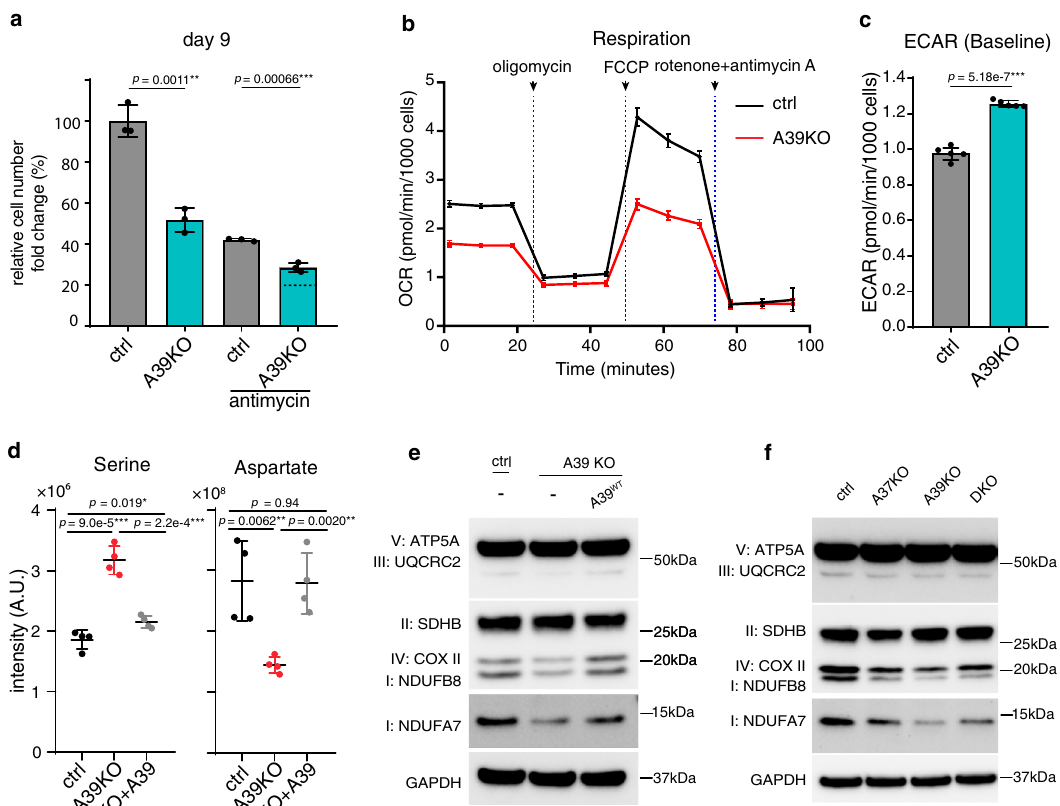
Fig. 6 SLC25A39 converges with SLC25A37-mediated iron homeostasis to support mitochondrial OXPHOS. a Growth fi tness defect in A39 CRISPR KO cells is buffered in the antimycin condition. The dotted line indicates the expected cell number, based on an additive model, if there were no speci fi c genetic interaction ( n = 3). b Oxygen consumption rate (OCR) for A39 KO cells during Seahorse mito stress test ( n = 5). c The basal extracellular acidi fi cation rate (ECAR) for A39 KO cells ( n = 5). d LC-MS measurement of serine and aspartate in control, A39 KO and the rescued cells ( n = 4). e Western blot for subunits of mitochondrial OXPHOS complexes in the ctrl, A39KO, and A39KO K562 cells expressing SLC25A39 cDNA. GAPDH was used as the loading control. f Western blot for subunits of mitochondrial OXPHOS complexes in the ctrl, SLC25A37KO, SLC25A39KO, and DKO K562 cells. GAPDH was used as the loading control. Statistical signi fi cance was calculated using two-tailed t test. Signi fi cance level were indicated as *** p < 0.001, ** p < 0.01, * p < 0.05 and n.s. p > 0.05. Data are expressed as mean ± SD. Source data are provided as a Source Data fi